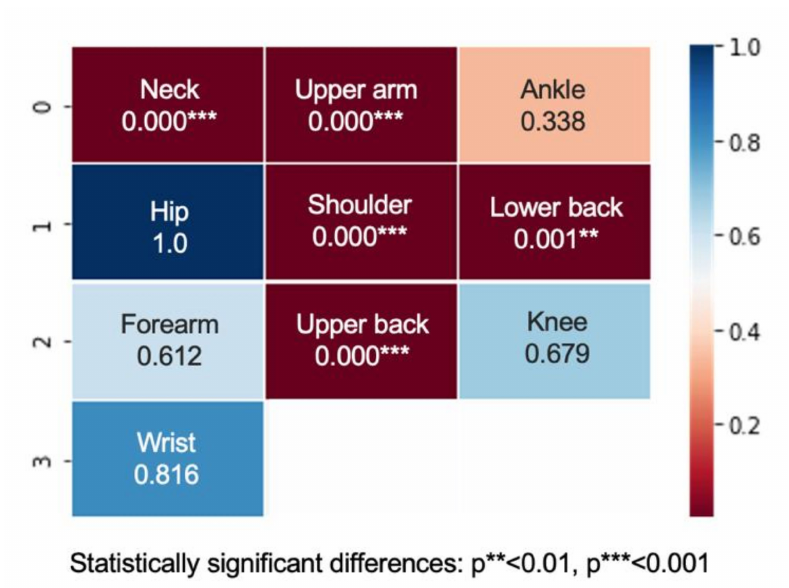
Figure 5. Visualization of p -value heat map for workload occurrence in manual